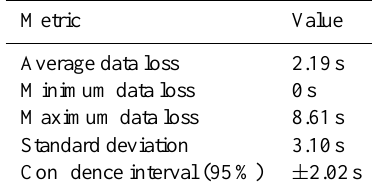
Table 4. Network test–intermediate node failure test.